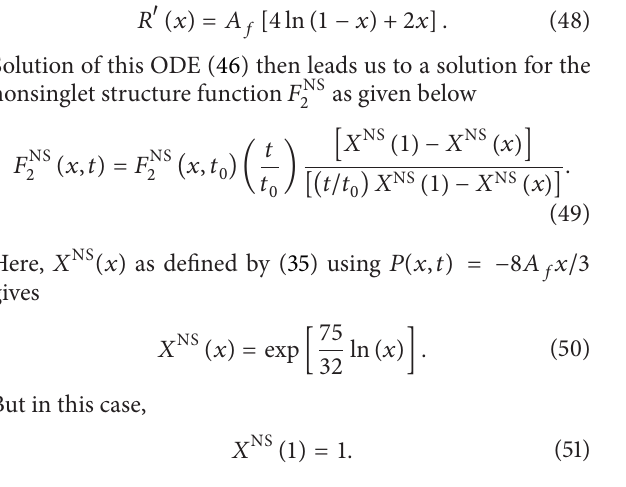
Figure 1: Nonsinglet structure function 𝐹 NS 2 (𝑥, 𝑄 2 ) as a function of 𝑥 at different fixed 𝑄 2 according to (19) and (45). Data from [19, 20].